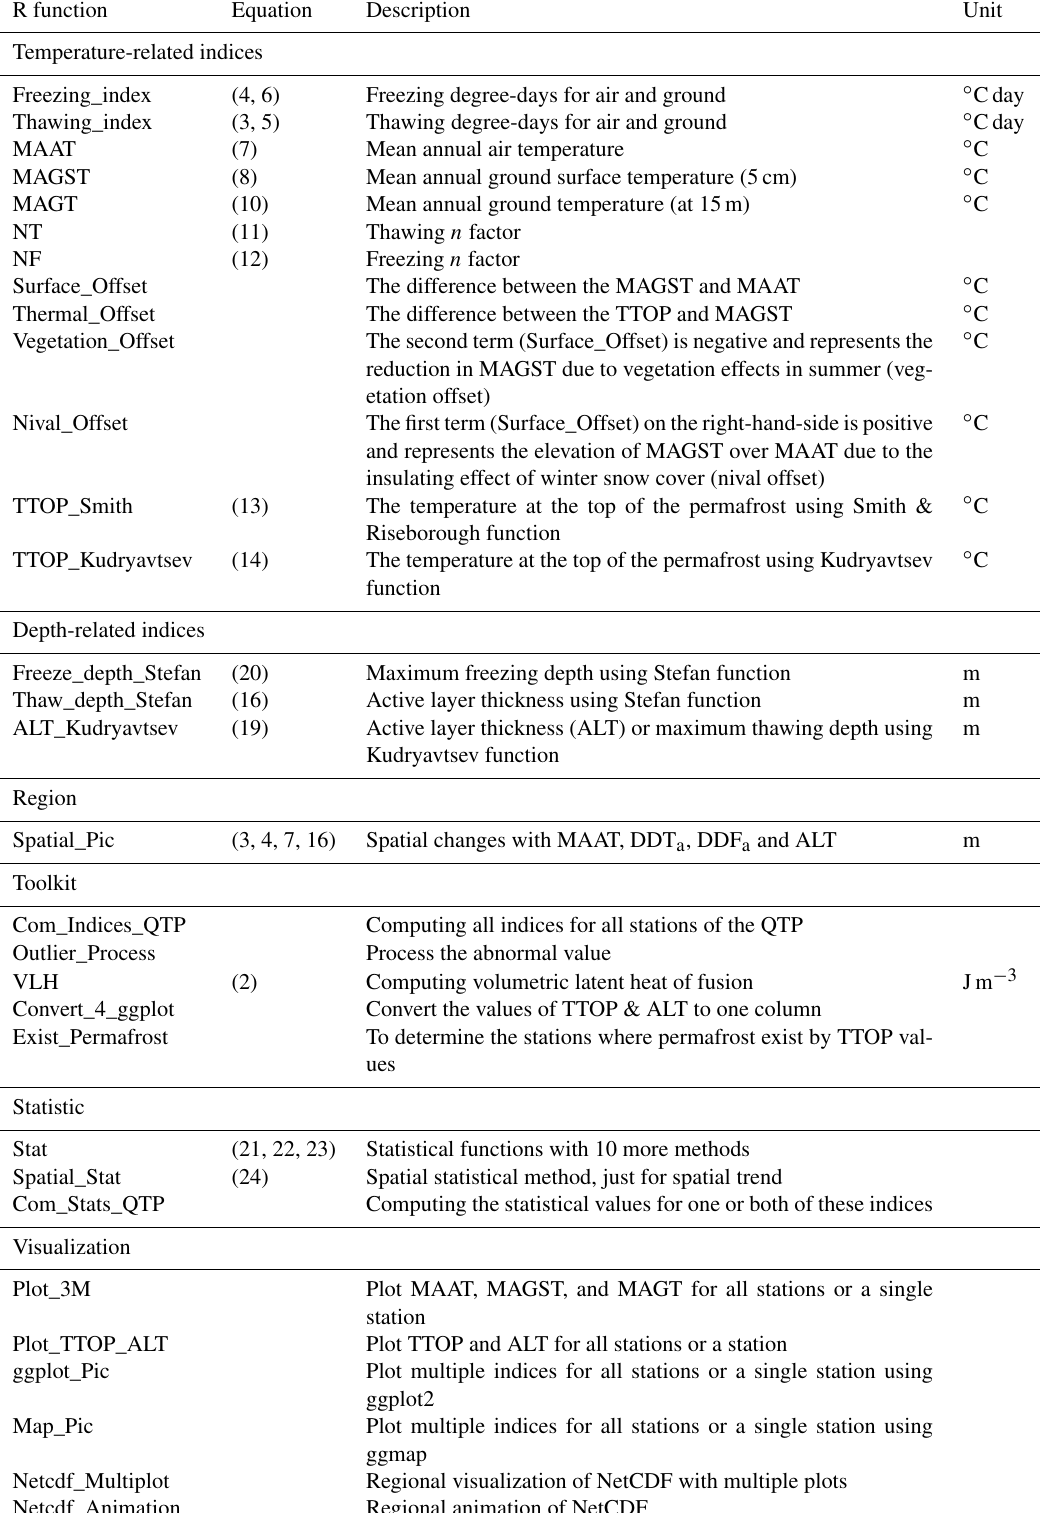
Table 1. Most important user functions in the R package PIC v1.3. The equation column of this table corresponds to the equation in Sect. 2. R